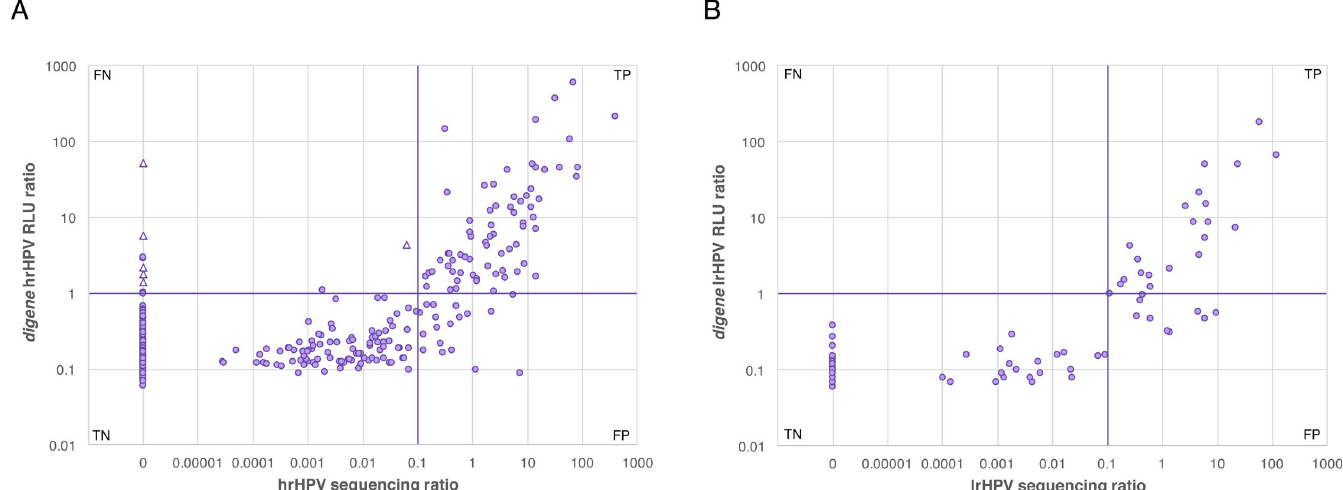
Fig 7. Comparison of hrHPV and lrHPV amplification and genotyping to the digene HC2 HPV assay. DNA from 718 vaginal samples was extracted and tested by PCR amplification and sequencing using HPV primers, and additionally used directly in the digene assay using the HC2 hrHPV (panel A) or lrHPV (panel B) probe mix. For each sample, the x-axis shows the normalized ratio of reads assigned to validated HPV types over reads assigned to a spiked-in internal control, while the Y-axis shows the digene HPV probe RLU values normalized over the assay’s cut-off RLU. The two purple lines show the cutoff for each of the assays. A. Comparison of hrHPV test results in a subset of 601 samples. Six samples that were positive in the digene hrHPV assay and negative in the hrHPV genotyping assay, but in which lrHPV sequences were detected by genotyping, are shown as light purple triangles. B. Comparison of lrHPV test results in a subset of 148 samples.